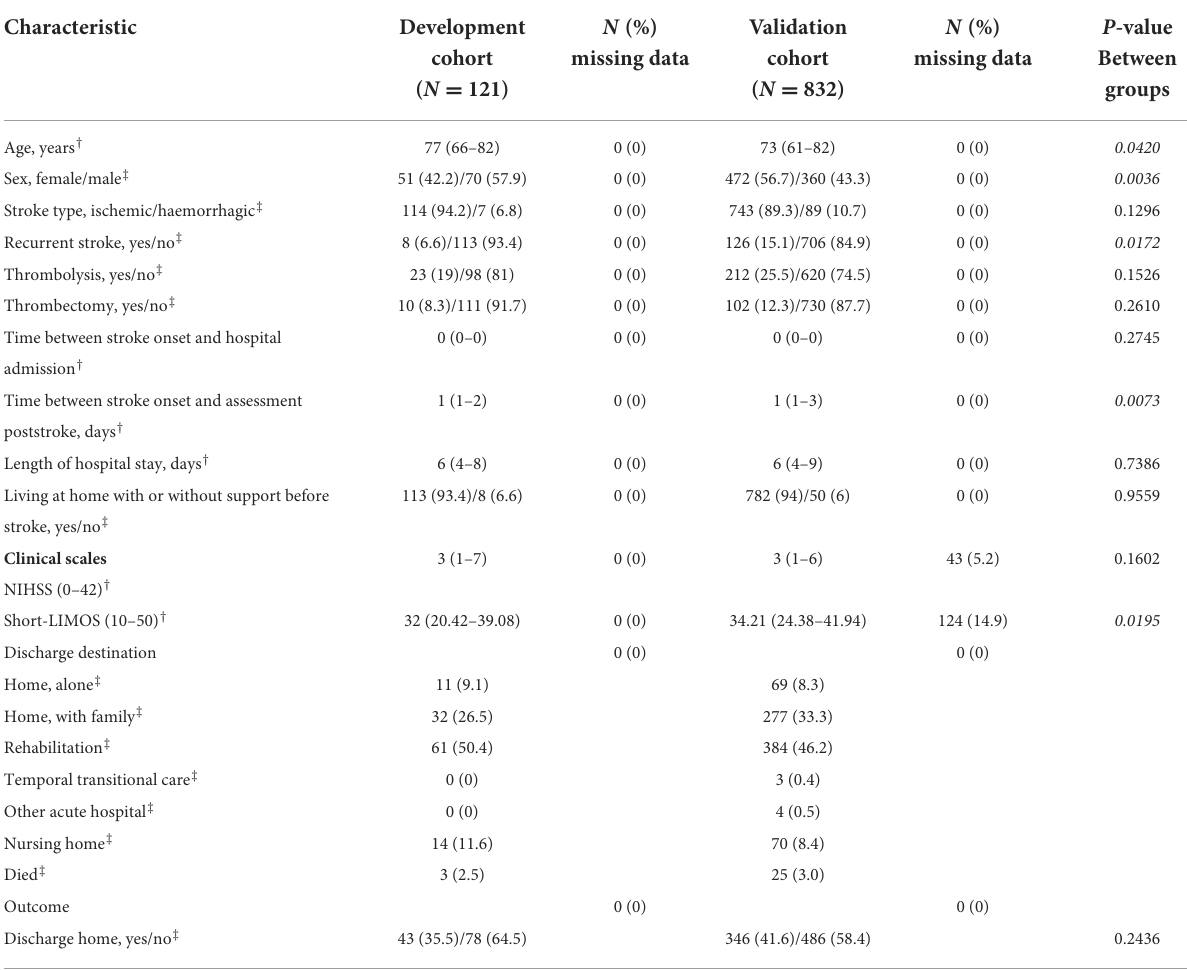
TABLE 1 Patients’